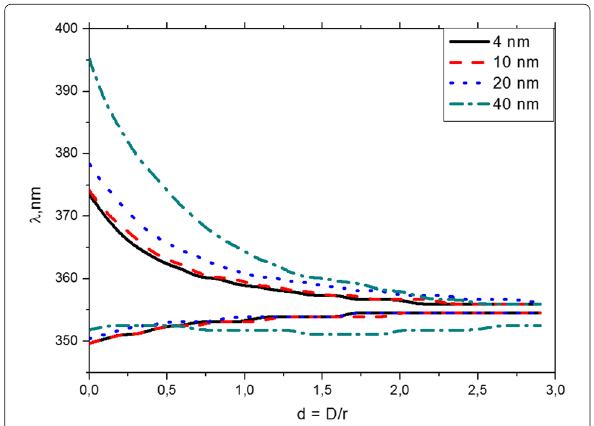
Fig. 3 The longitudinal and transverse field enhancement peaks dependent on the interparticle separation for dimers with